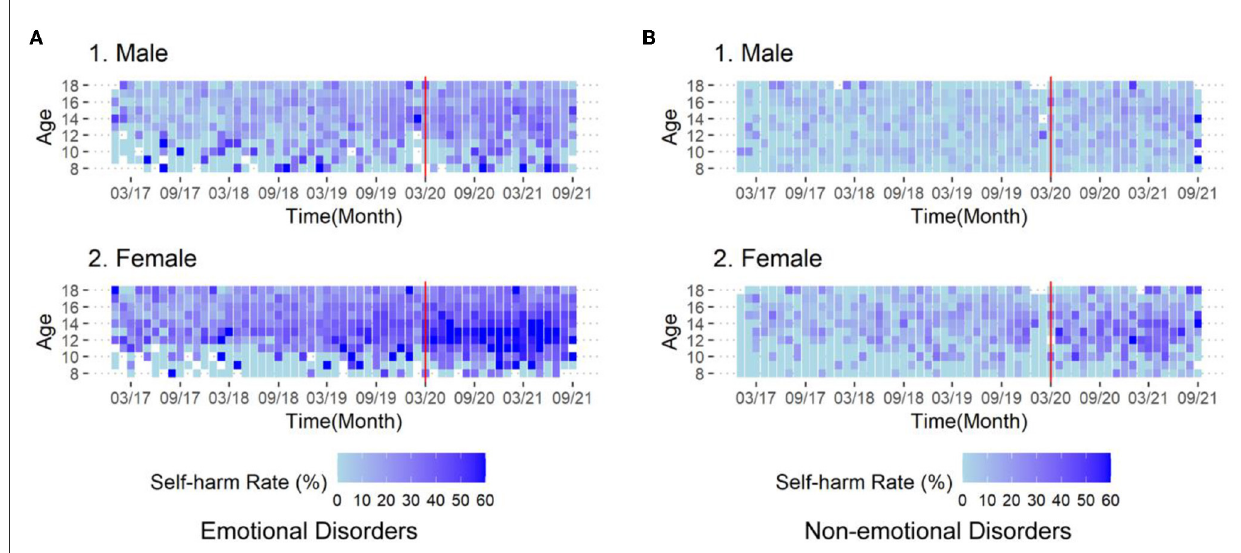
FIGURE4 Heat map of self-harm rates for (1) male and (2) female patients with (A) emotional disorders and (B) non-emotional disorders. The colors in the cells represent the self-harm rate for each age group in each month. The red vertical line indicates March 2020, from which time the adolescent’s social environment was affected (national-wide home study started). Emotional disorders include depressive and bipolar disorder, anxiety disorder, post-traumatic stress disorder, obsessive compulsive disorder and childhood emotional